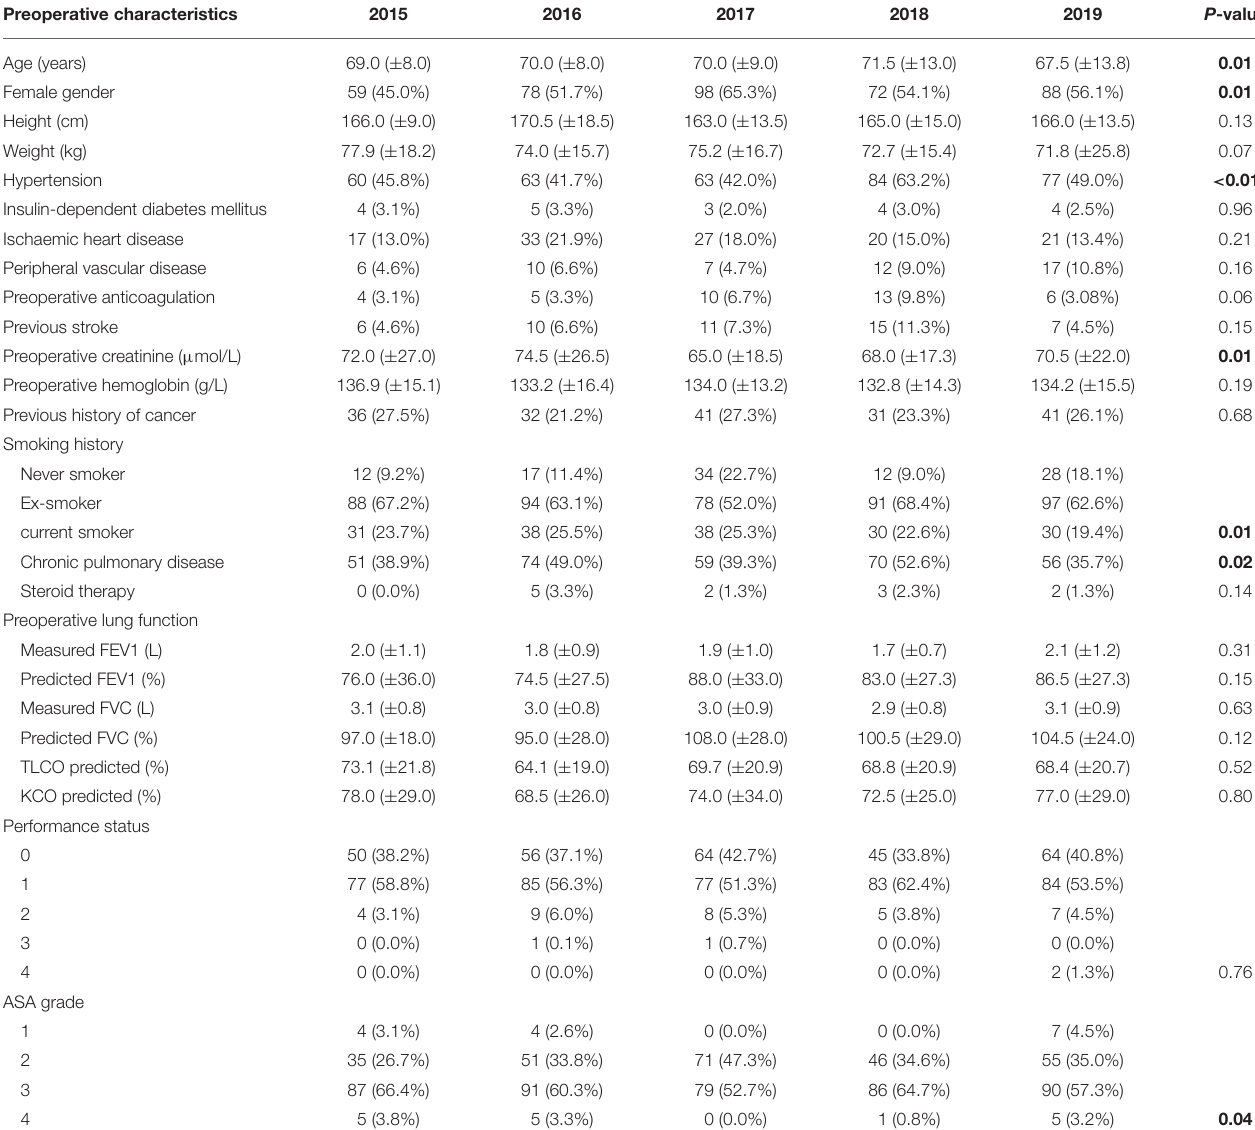
TABLE 2 | Baseline patient characteristics over